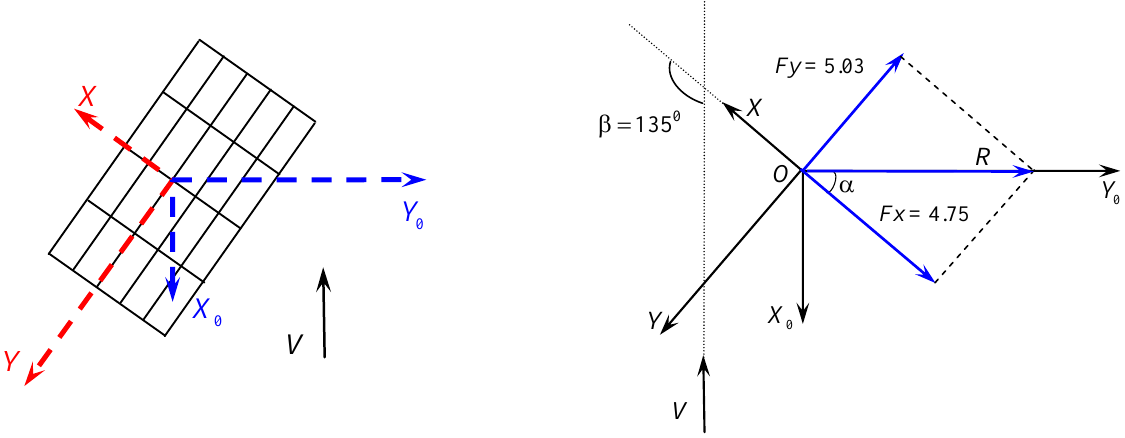
Figure 13. Direction of forces in the section at the angle of attack β = 135 ◦ .